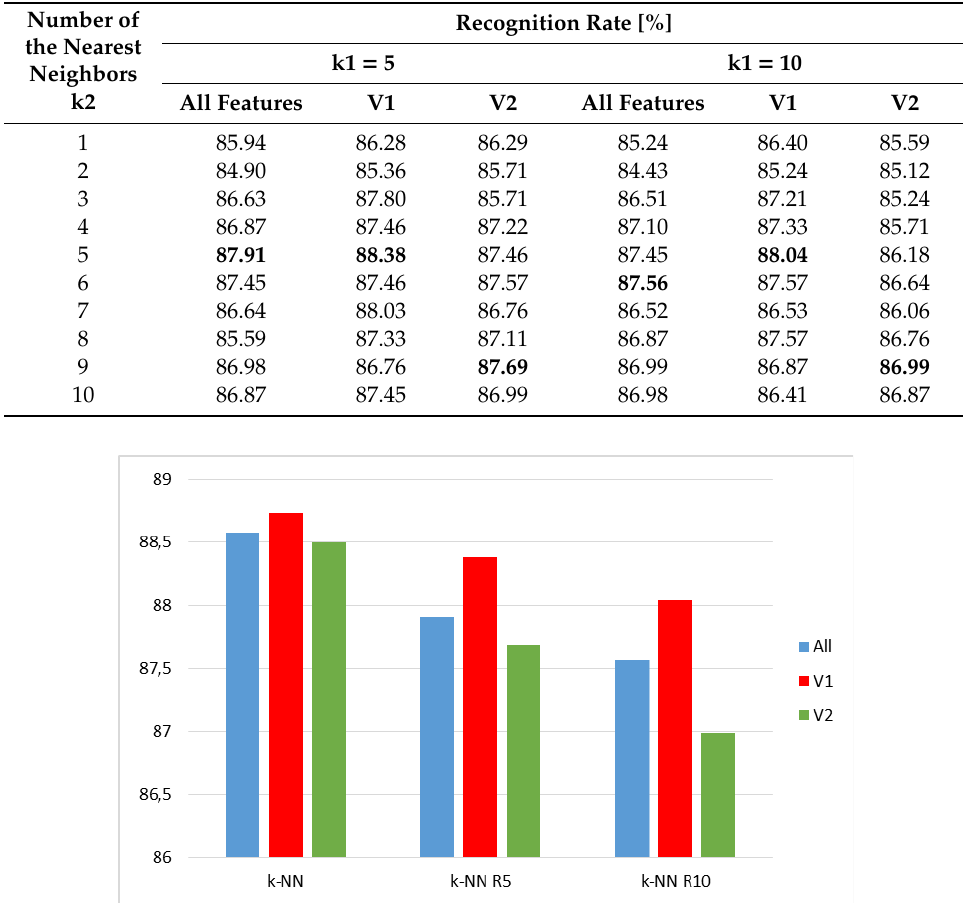
Figure 9. Recognition rates for the UTD-MHAD dataset: original k-NN (left) and k-NN using representatives.